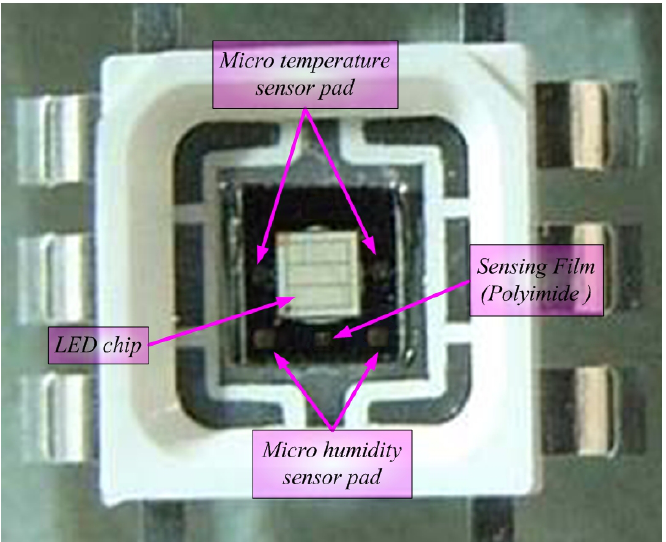
Figure 9. High-power LED with micro